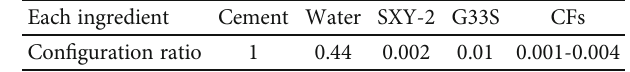
Table 5: Cement slurry